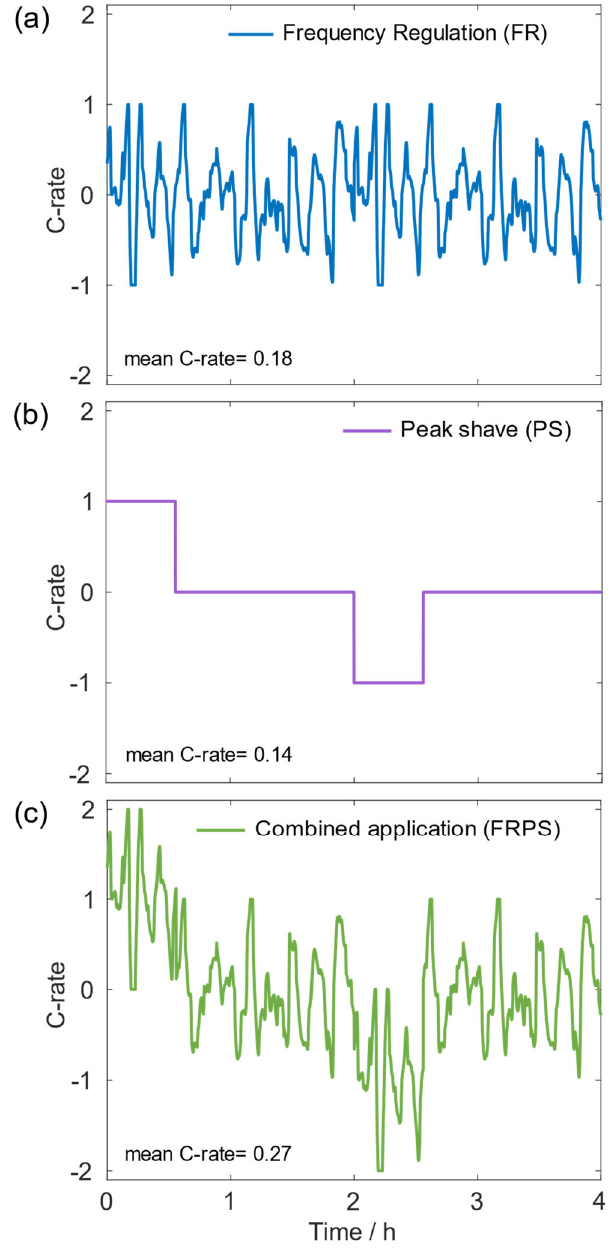
Figure 2. The three investigated duty cycles ( a ) FR 44–56% SOC-range, ( b ) PS 22–78% SOC-range, ( c ) FRPS 16–84% SOC-range.